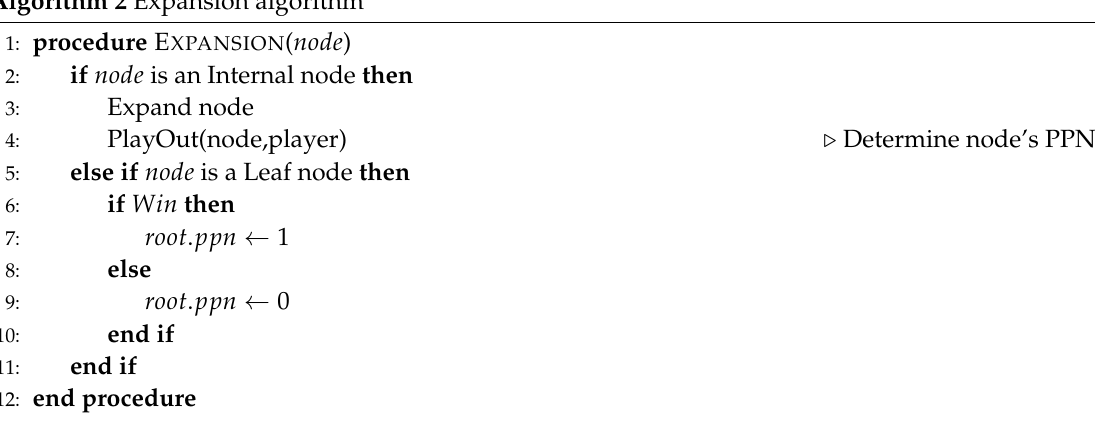
Algorithm 2 Expansion algorithm